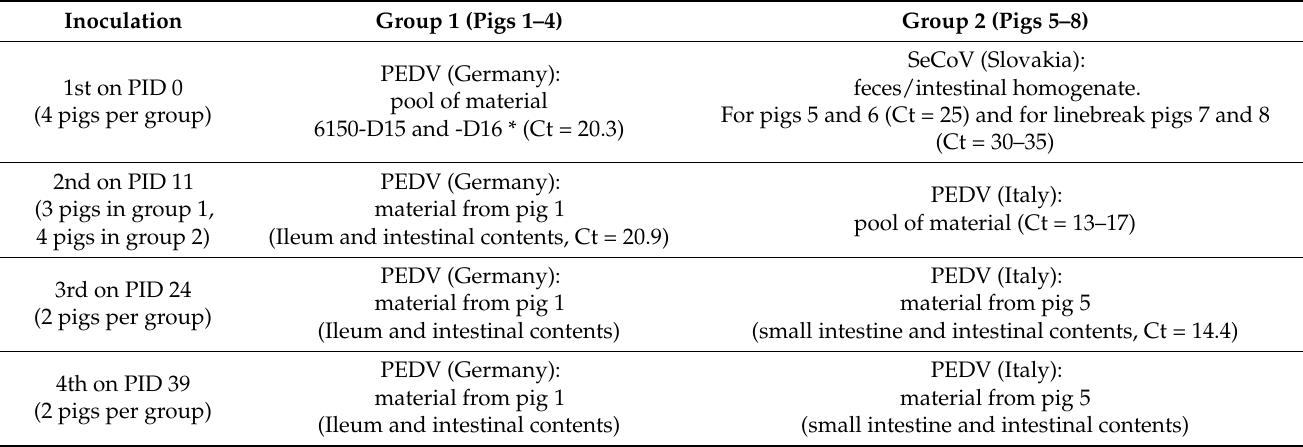
Table 1. Overview of inoculation materials used in the infection